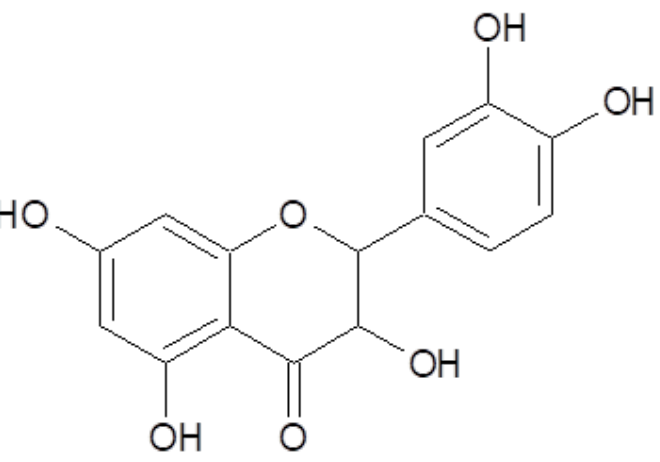
Figure 8. Chemical structure of quercetin.